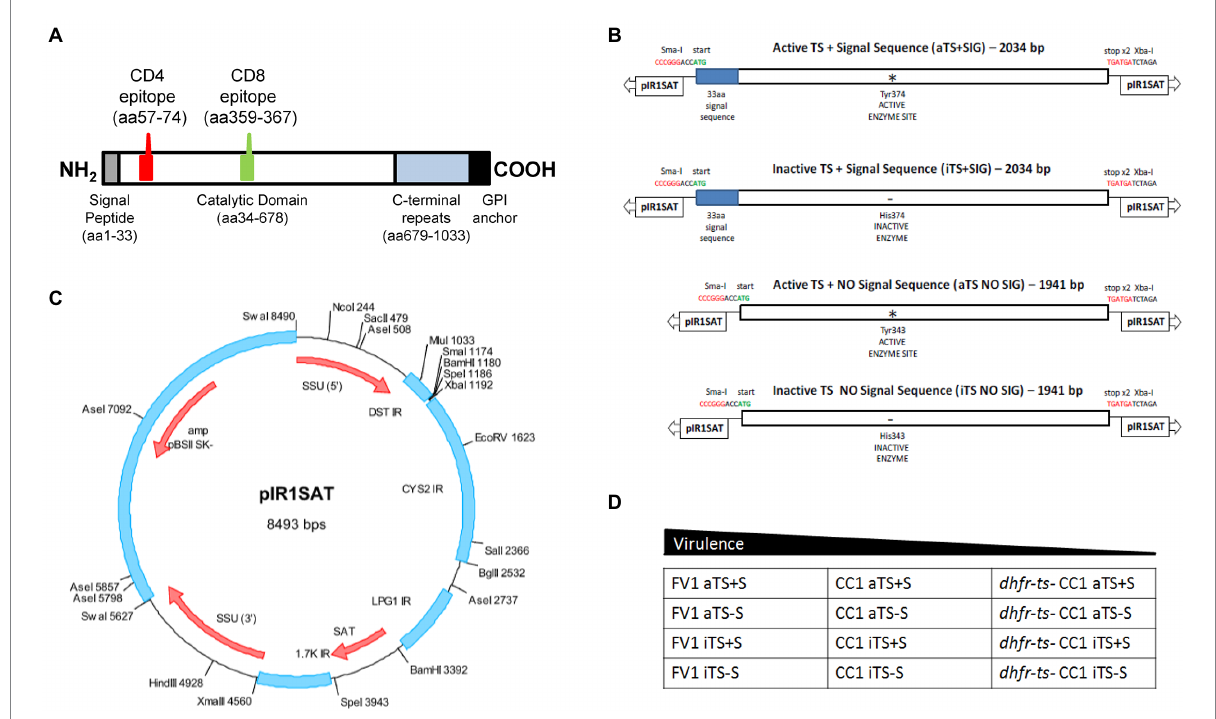
FIGURE 1 Generation of recombinant TS-expressing Leishmania parasites. (A) Schematic of T.cruzi trans -sialidase (TS154) showing key domains and the location of the known immunodominant I-A d -restricted CD4 epitope (p7) and H-2K d -restricted CD8 epitope (TSKd1). (B) Schematic showing the four TSA constructs tested here: WT or active secreted TS (aTS+S), active nonsecreted TS (aTS − S), inactive secreted TS (iTS+S), inactive nonsecreted TS (iTS − S). Inactive TS versions were generated by point mutation in the enzymatic domain as indicated; non-secreted versions were generated by deleting a 33-amino acid signal sequence at the N-terminus. (C) These TS inserts were then cloned into a pIR1SAT vector, optimized for transfection of L. major . (D) The pIR1SAT shuttle plasmid expressing various forms of TS were used to transfect virulent FV1 and CC1 L. major parasites, as well as the avirulent dhfr-ts − CC1 L. major